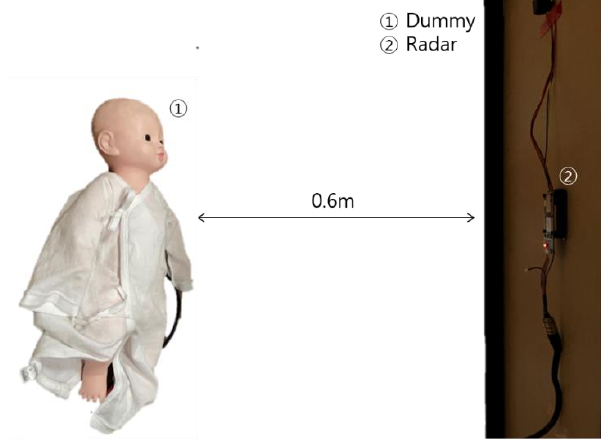
Figure 3. Experiment to prove that respiration can be measured using radar.